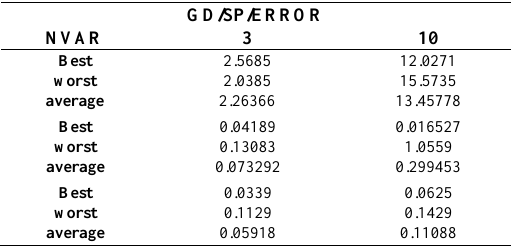
Table 14: Test results for second test function.